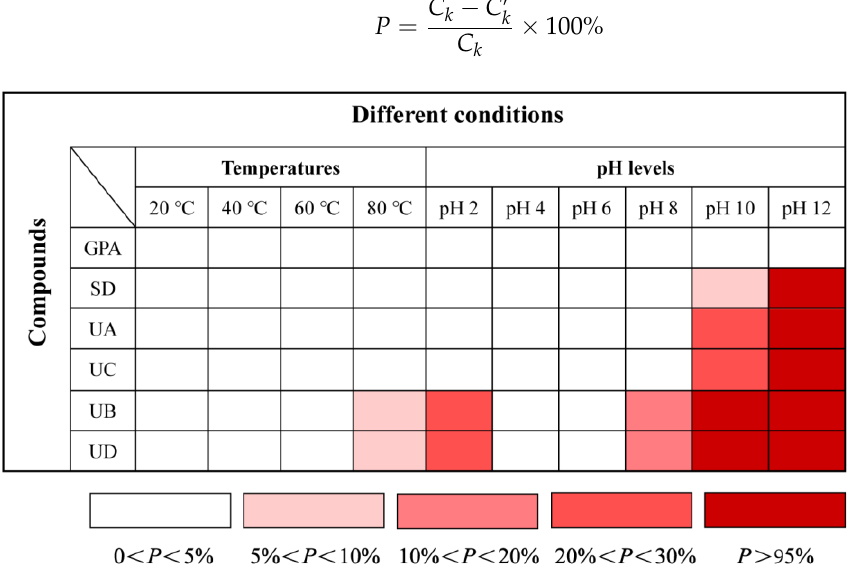
Figure 6. Illustration of stability degree for the tested compounds under the conditions of different temperatures and pH levels.